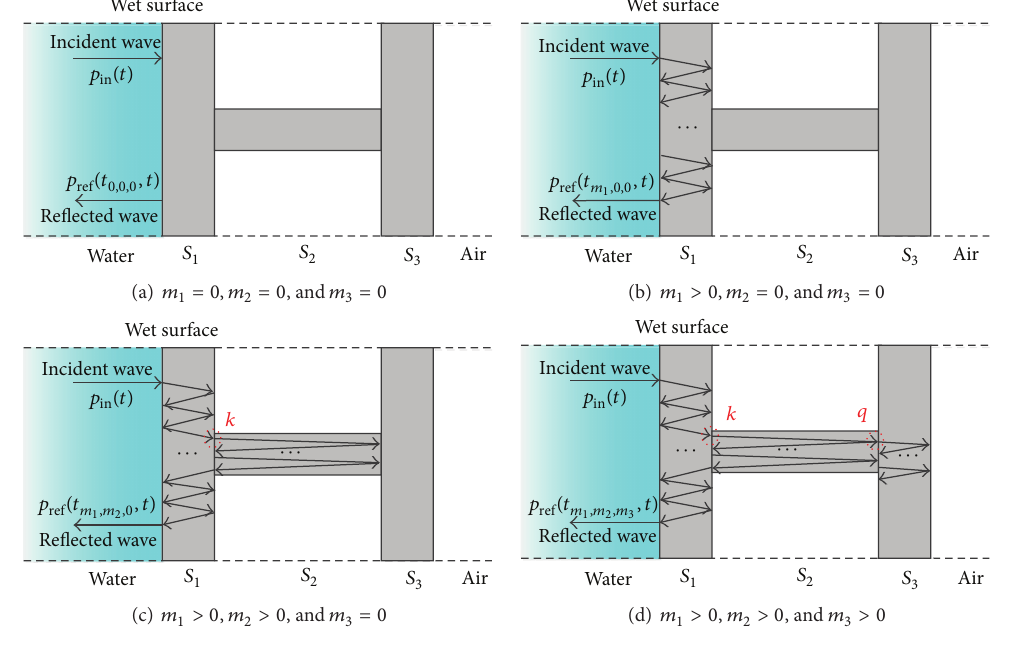
Figure 7: The different cases of the input wave propagates in the panel with girder